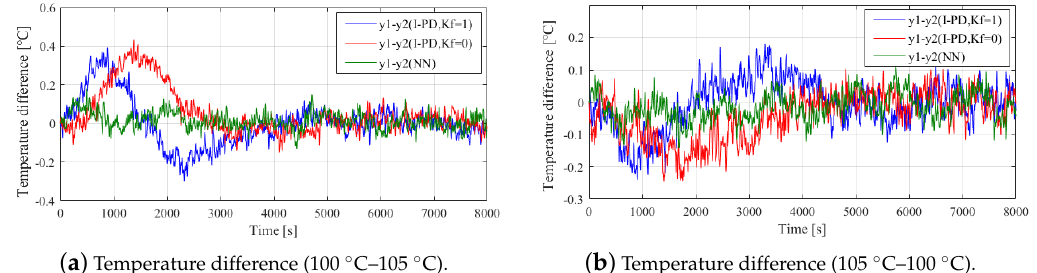
Figure 12. Experimental results. ( a ) Temperature differences between ch1 and ch2 from 100 ◦ C to 105 ◦ C. ( b ) Temperature differences between ch1 and ch2 from 105 ◦ C to 100 ◦